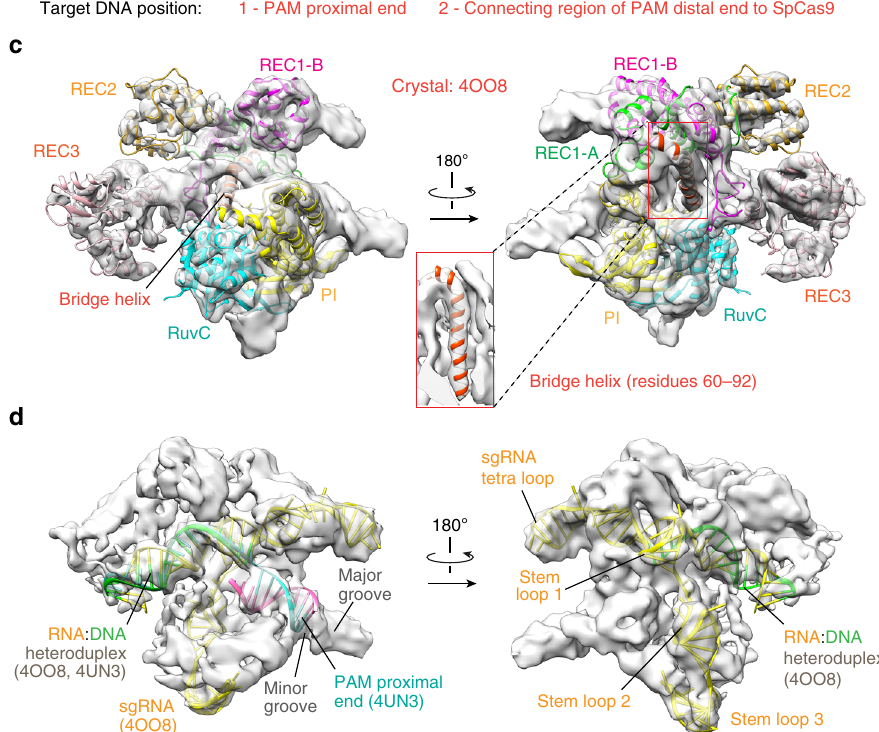
Fig. 1 The cryo-EM structure of the ternary complex. a Schematic diagrams of SpCas9, 98-nt sgRNA, 55-bp target DNA. Potential Watson – Crick and non- Watson – Crick base pairs in sgRNA and DNA are indicated by lines and dots, respectively. b Representative 2D classes of the complex particles. The positions of the PAM proximal and PAM distal ends of the target DNA are indicated by arrows 1 and 2, respectively. c Rigid-body fi tting of the crystal structure 4OO8 in the absence of the HNH domain, with a correlation coef fi cient of ~0.80. The density map at a higher contour level (~4.0 σ ) shows clearly most of the SpCas9 α -helices in the crystal structure (cartoon model). The central, small panel shows the EM density that resolves the long bridge helix. d The density map clearly resolves sgRNA, the RNA:DNA heteroduplex, PAM, and the PAM proximal end in the crystal structures (4OO8 and 4UN3, cartoon model). The correlation coef fi cient of the rigid-body fi tting of 4UN3 is